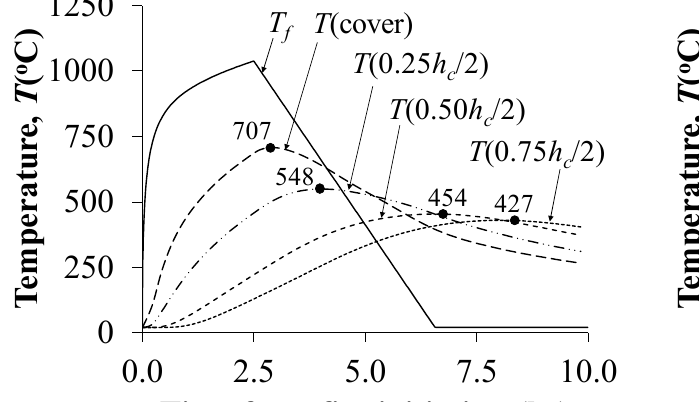
Figure 7. Temperature distribution within the rectangular cross-section of column (R3) at different time increments.